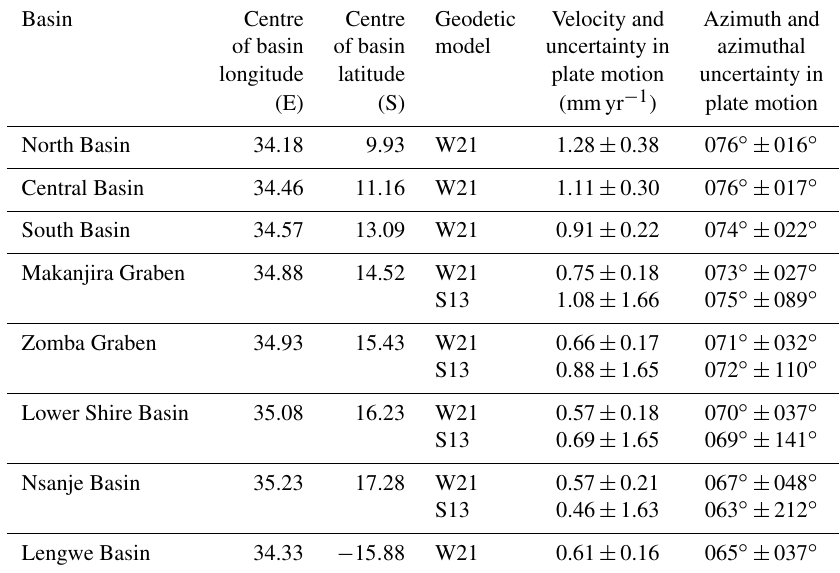
Table 2. Plate motion vector for each basin in Malawi using the geodetic model by Wedmore et al. (2021) and the coordinates from which it was derived. The uncertainties associated with each vector are derived using the methods of Robertson et al. (2016). For basins in southern Malawi, the Nubia–Rovuma plate motion vectors obtained from the Saria et al. (2013) geodetic model (S13) and used in the South Malawi Seismogenic Source Database are also